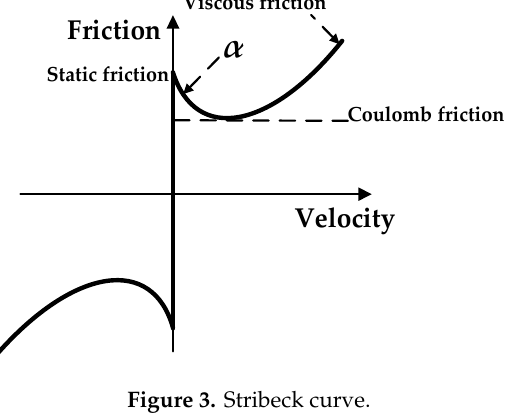
Figure 3. Stribeck curve.